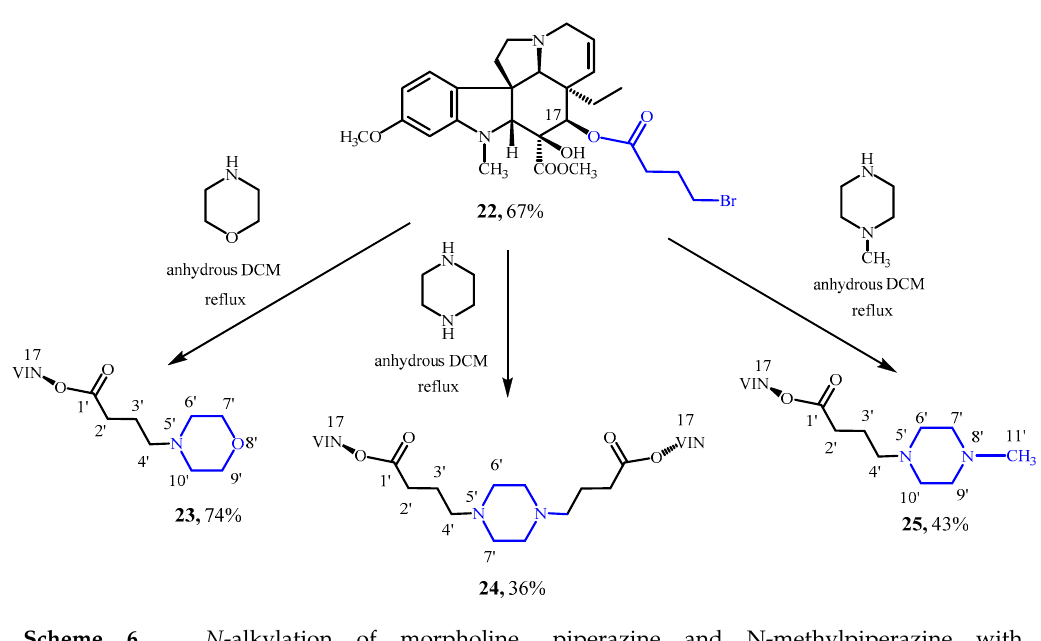
Table 1. In vitro antiproliferative activity of selected compounds against human gynecological